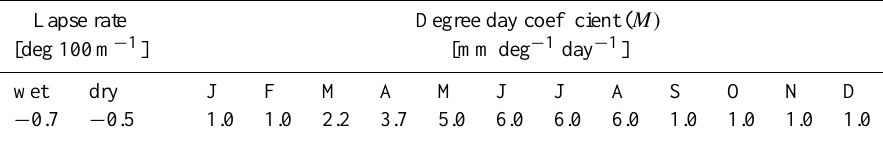
Table 2. Snowmelt parameters used in the rainfall-runoff model